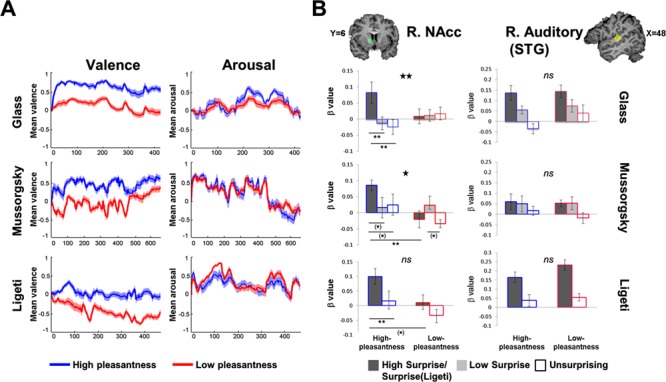
Surprise-related activation and experienced pleasantness interact within the NAcc but not within the STG. (A) Subgroups’ clustering based on continuous valence reports. The continuous mean ratings on the scales of valence (L panel) and arousal (R panel) are denoted per group and musical piece (Glass, top; Mussorgsky, center; Ligeti, bottom). Note that while valence ratings clearly differentiate the two groups, arousal ratings do not. Thickness of shading represents 1 SEM. (B) ROI analysis in the NAcc and STG. Consistently across musical pieces, the high- but not low-pleasantness groups exhibited stronger activation in response to surprising events in the NAcc, relative to less surprising events (L panel). In contrast, groups showed similar surprise-related activation in the STG (R panel). Level of surprise is denoted by grayscale (highest is equal to dark). The high- and low-pleasantness groups are marked by blue and red contours, respectively. Stars above the graph bars denote interaction effects’ significance: *P < 0.05; **P = 0.01. Asterisks below the graph bars indicate the significance of pairwise comparisons: (*)P < 0.05, uncorrected; **P < 0.01; qFDR < 0.05. Error bars represent 1 SEM.